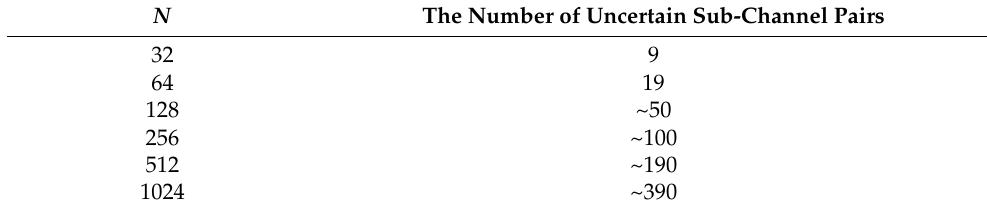
Table 4. The number of uncertain sub-channel pairs in different code lengths. N